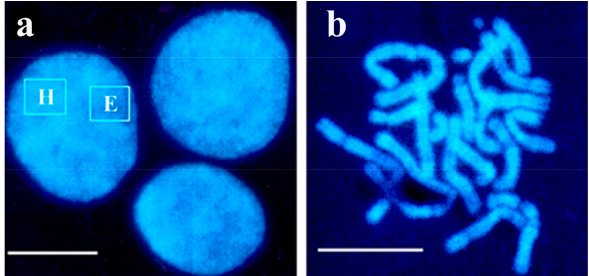
Figure 1. Interphase chromatin ( a ) and metaphase chromosomes ( b ) were isolated from Chinese hamster ovary (CHO) cells. DAPI staining of nuclear structures shows the more condensed hete- rochromatin (H) (facultative or constitutive) and the less condensed euchromatin (E). Scale bar 5 µ m. Reprinted with permission from Ref. [30]. Copyright year 2009, Springer Science + Business Media BV, Dordrecht, Figure